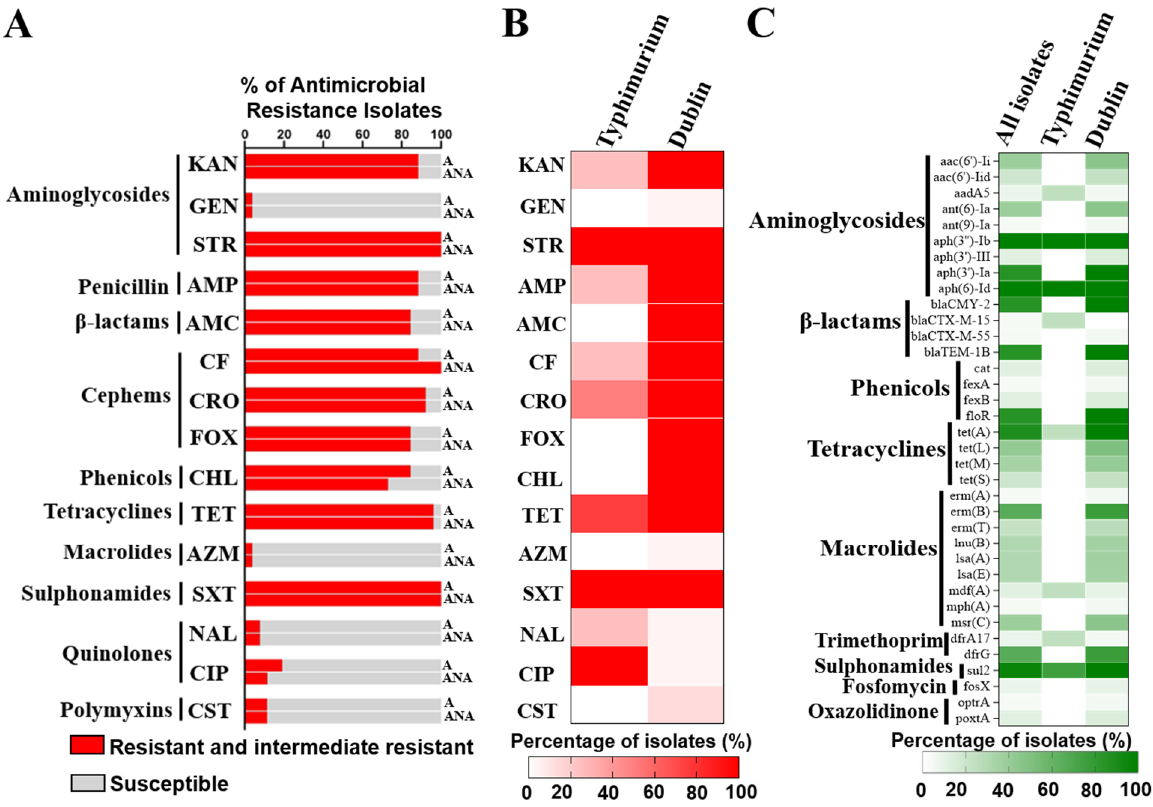
Figure 1. The antimicrobial resistance of companion-animal-origin Salmonella isolates. ( A ) Antimicrobial-resistant phenotypes under aerobic and anaerobic conditions. A total of 15 antibiotics were used, including kanamycin (KAN), gentamicin (GEN), streptomycin (STR), ampicillin (AMP), amoxicillin/clavulanic acid (AMC), ceftiofur (CF), ceftriaxone (CRO), cefoxitin (FOX), chloramphenicol (CHL), tetracycline (TET), azithromycin (AZM), cotrimoxazole (SXT), nalidixic acid (NAL), ciprofloxacin (CIP), and colistin (CST). The results of MIC under aerobic (“A”) and anaerobic (“ANA”) conditions are displayed. ( B ) Heatmap of antimicrobial-resistant phenotypes of distinct Salmonella serovars. ( C ) Heatmap of antimicrobial-resistant genes carried by Salmonella .